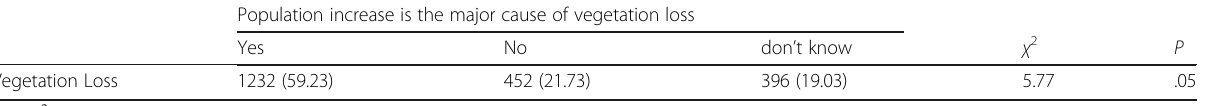
Table 5 Cross tabulation and chi-square test for responses on questions related to vegetation loss ( N =